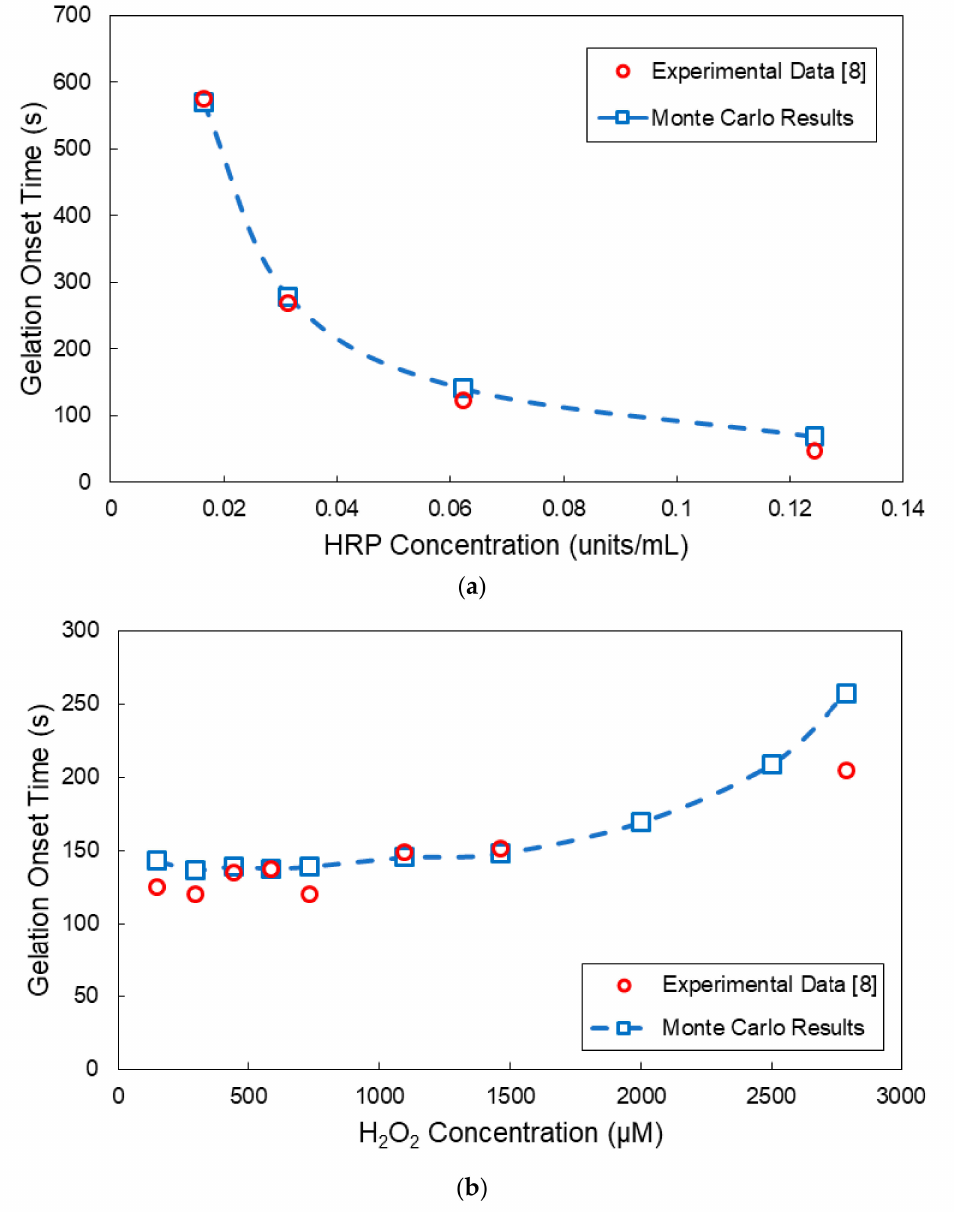
Figure 8. Comparison of the MC model results with reported experimental measurements on the gelation onset time for the HA-Tyr system (i.e., 1.75% w/v , MW = 90 kDa) [8]: ( a ) effect of the HRP concentration on the gelation onset time (H 2 O 2 concentration: 728 µ M) and ( b ) effect of the H 2 O 2 concentration on the gelation onset time (HRP concentration: 0.062